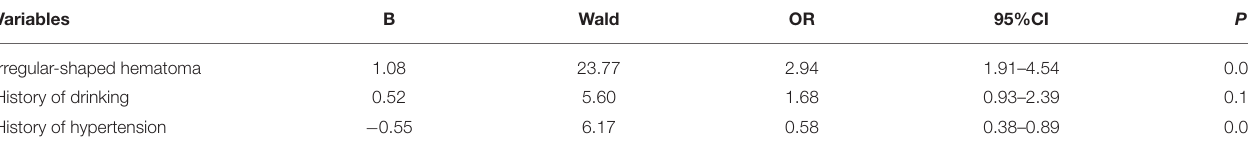
TABLE 4 | Binary logistic regression for predictors of postoperative rehemorrhage.